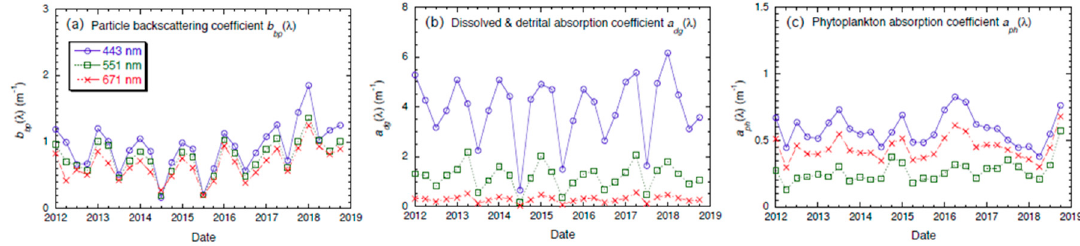
Figure 10. Time series of the mean IOP in Lake Taihu for ( a ) b bp ( λ ), ( b ) a dg ( λ ), and ( c ) a ph ( λ ) at the VIIRS bands of 443, 551, and 671 nm.